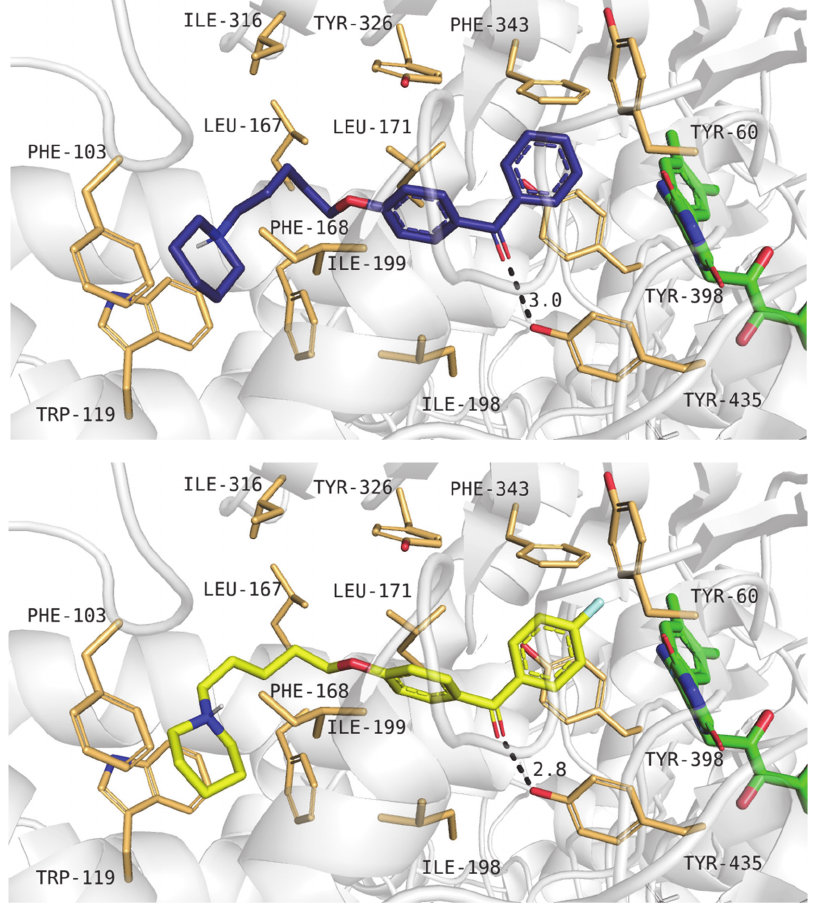
Figure 11. Binding mode of compounds 4 ( upper panel ) and 6 ( lower panel ) within the human MAO B active site. Amino acid residues are colored in sand, and cofactor FAD is in green. B active site. Amino acid residues are colored in sand, and cofactor FAD is in